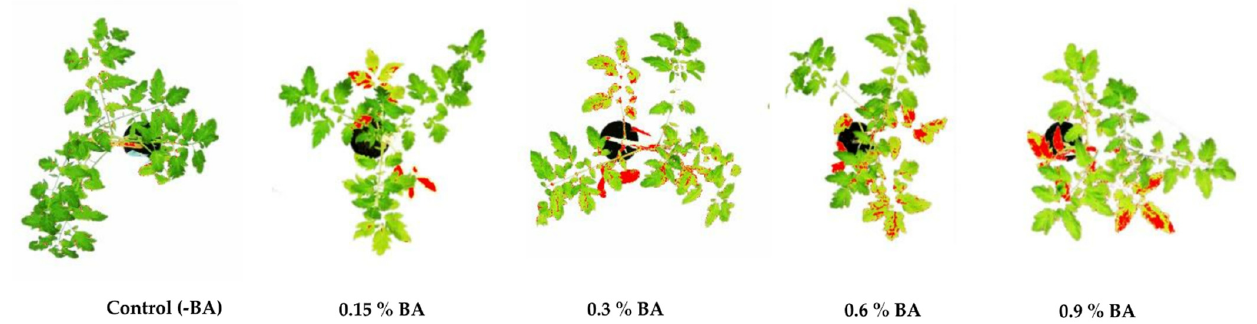
Figure 1. Total physiological lesion area on tomato plants 14 days after BA application, measured by software ImageJ.